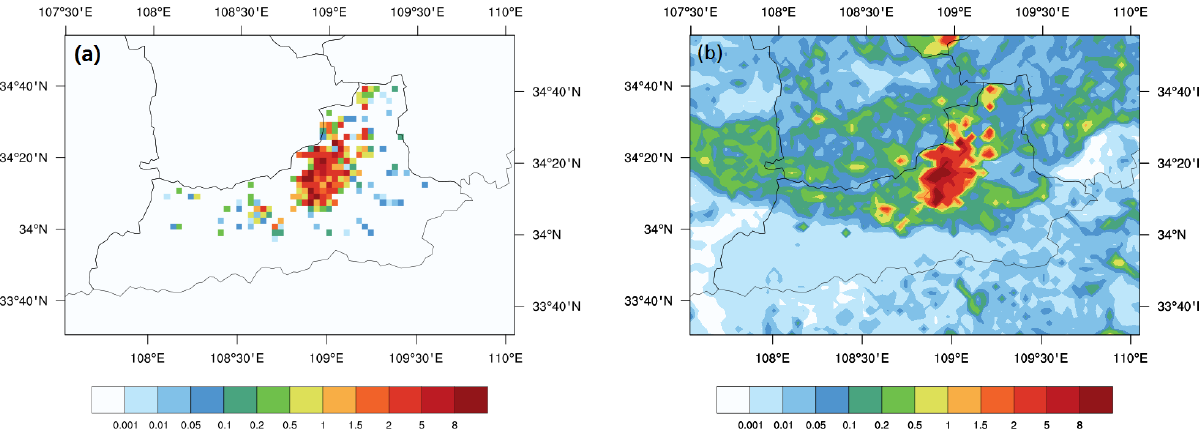
Figure 6. Spatial distribution of PM 10 emissions in Xi’an and its surrounding area. (a) Construction fugitive dust in Xi’an only. (b) All surface PM 10 emissions in Xi’an. The grid size is 3km × 3km. (Unit: gkm − 2